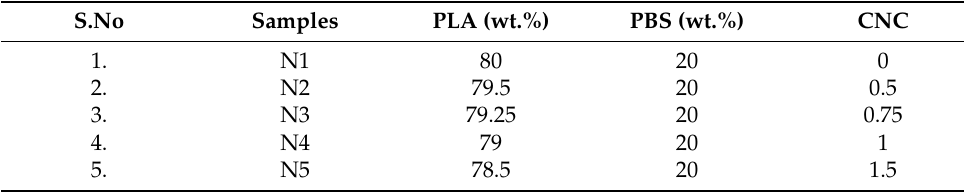
Table 1. Composition of PLA-PBS-CNC